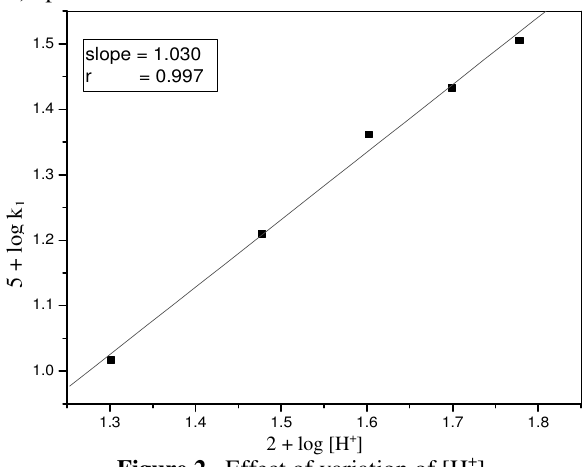
Figure 2 . Effect of variation of [H +